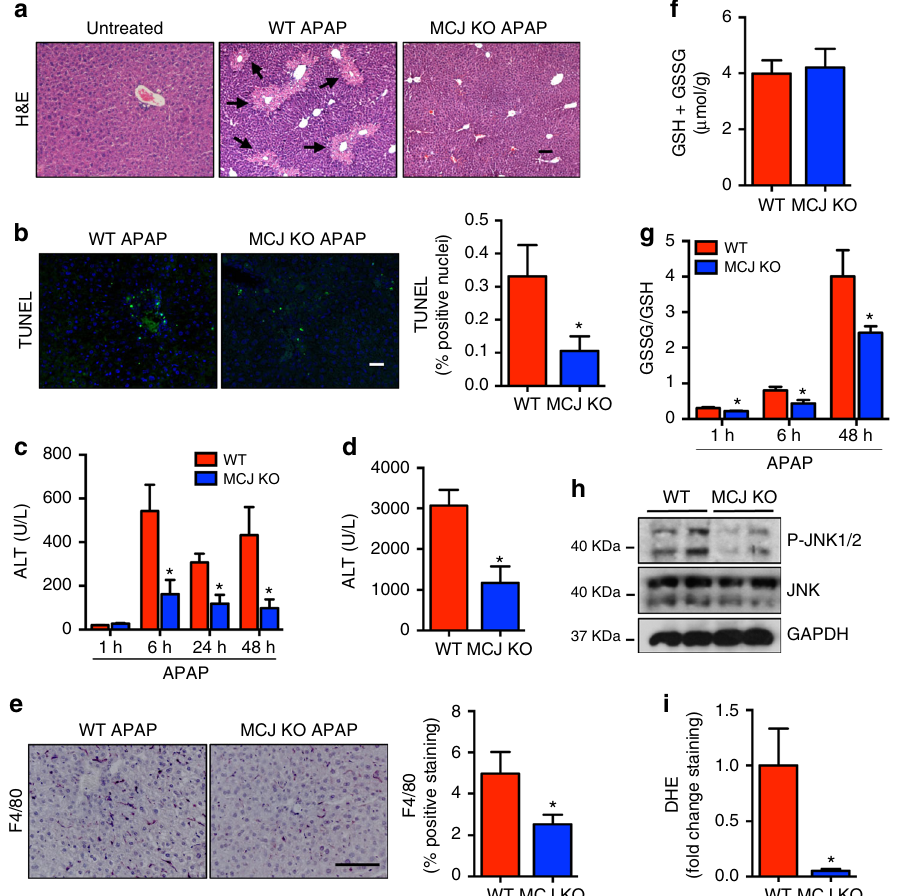
Fig. 2 MCJ deletion protects against APAP hepatotoxicity in vivo. WT ( n = 6) and MCJ KO mice ( n = 6) were treated with APAP 360 mg/kg for 48 h. Liver damage was evaluated by a hematoxylin and eosin (H&E) and b TUNEL staining in liver sections. c , d Serum alanine aminotransferase (ALT) levels in WT and MCJ KO fed animals ( c ) and starved animals at 24 h after APAP ( d ). e In fl ammation assessed by F4/80 staining in liver. f Total GSH levels measured by HPLC-MS in WT and MCJ KO livers after 6 h of APAP treatment ( n = 5). g GSSG/GSH levels measured by HPLC-MS in WT and MCJ KO livers. h JNK activation by western blotting in WT and MCJ KO liver extracts after 1 h of APAP treatment ( n = 5). i ROS in vivo measured by dihydroethidium (DHE) staining in liver sections. Scale bar corresponds to 100 μ m. Values are represented as mean ± SEM. * P < 0.05 (Student ’ s t test) (MCJ KO vs. WT) NATURE COMMUNICATIONS | 8: 2068 | DOI: 10.1038/s41467-017-01970-x |